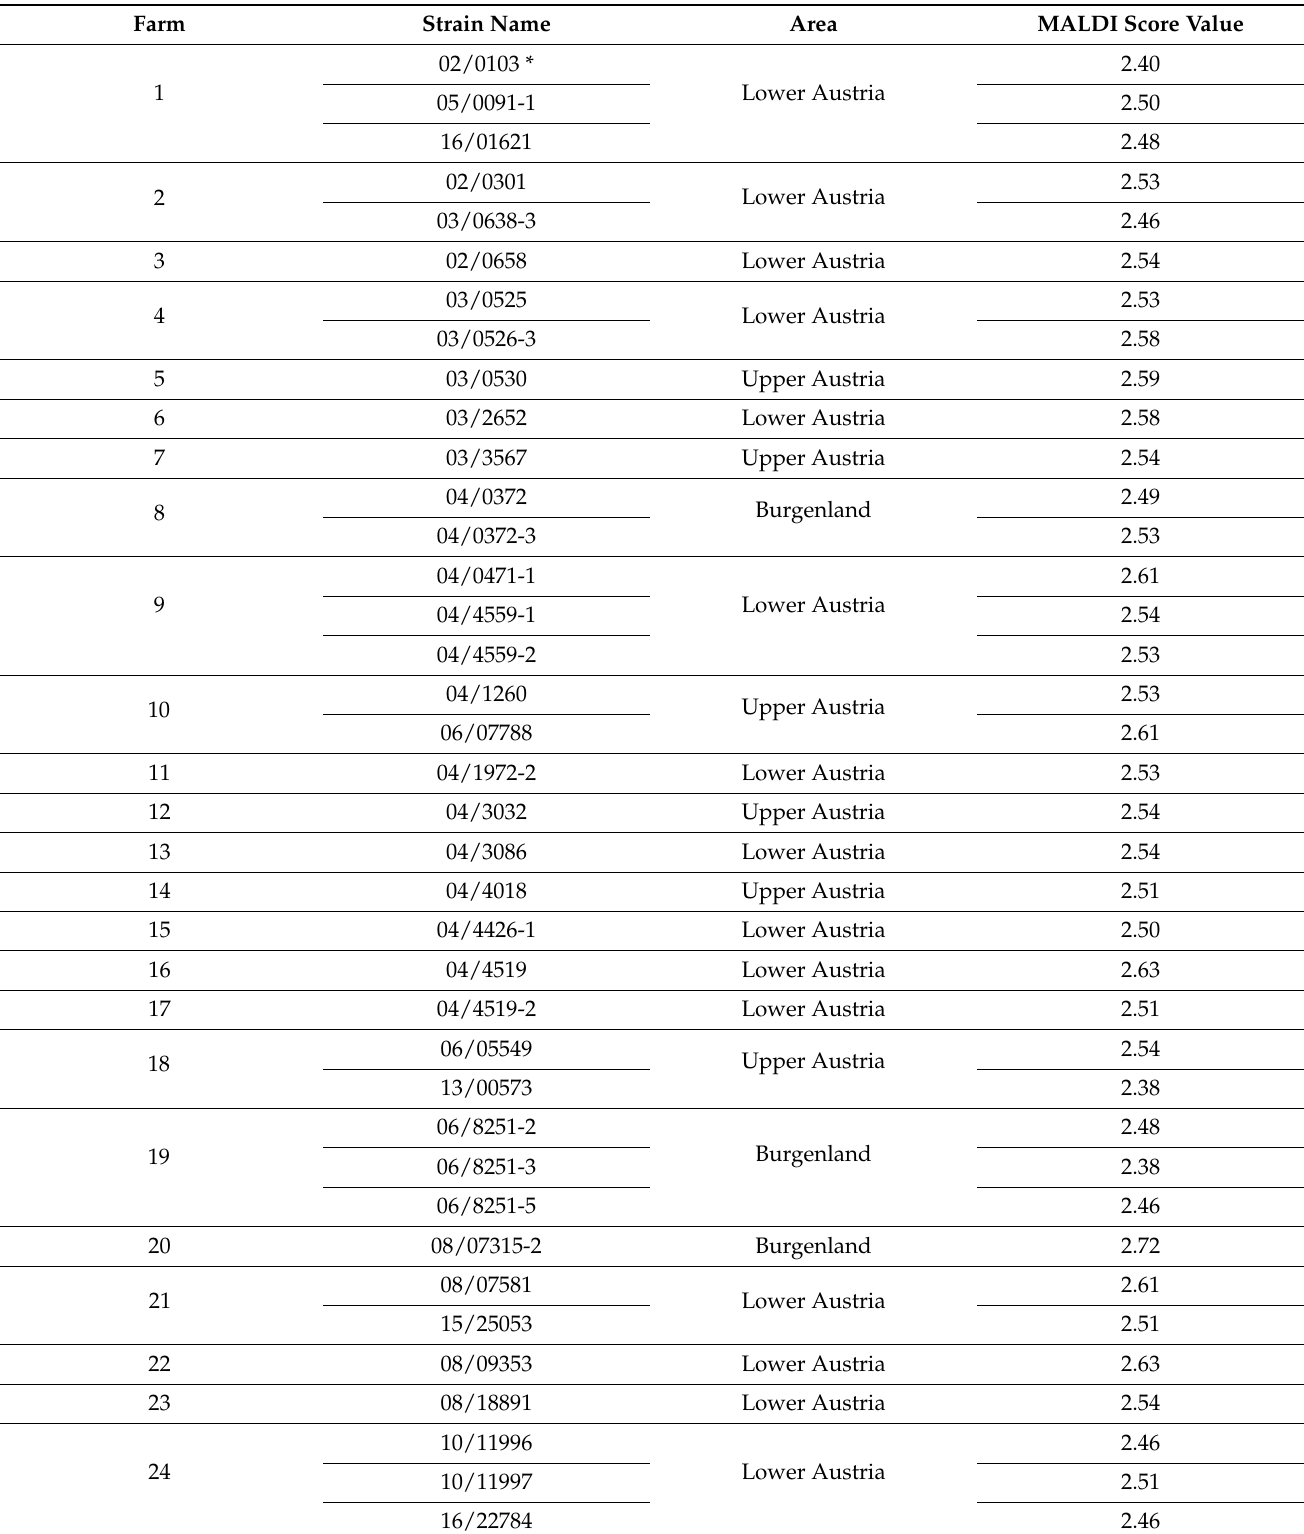
Table 2. Ornithobacterium rhinotracheale field strains isolated from Austrian turkey